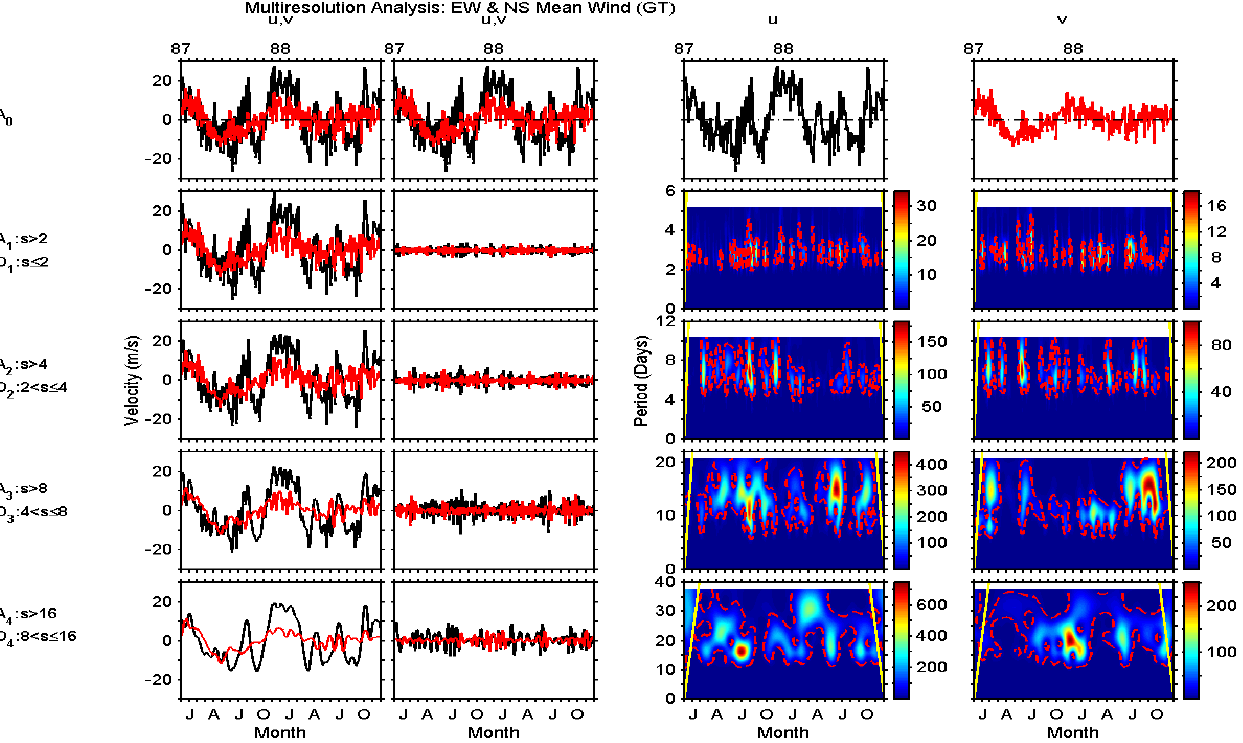
Fig. 3. Analysis of the mean wind at Grahamstown: Top row, the original signal A o . Rows 2–5, starting from the left show (1st column) the approximations ( A m where m is the level), (2nd column) the details ( D m ), (3rd column) the spectrum of the zonal details and (4th column) the spectrum of the meridional details. The black and red time series lines represent the zonal ( u ) and meridional ( v ) mean flow, respectively. The scale ( s ) ranges are shown on the left. The units of the colour bars are